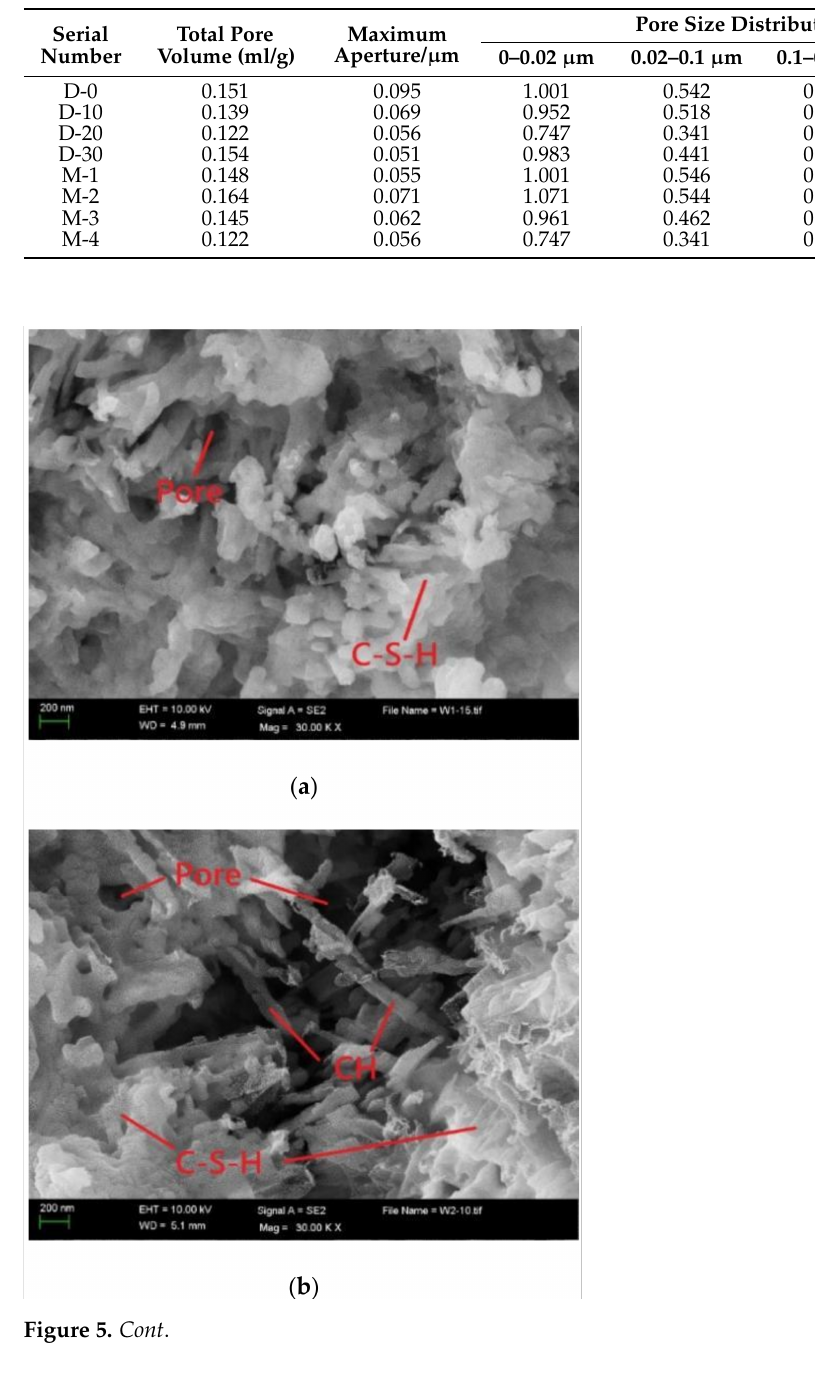
Table 7. Pore characteristic parameter in mortar samples at 28 days.